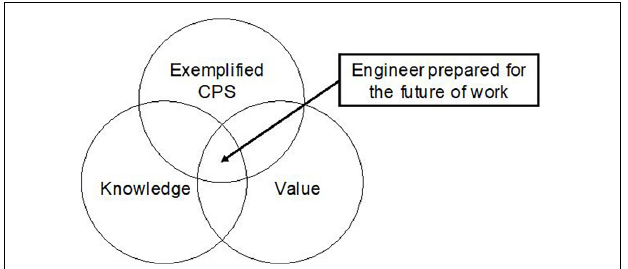
FIGURE 3 | An engineer prepared for the future of work. Exemplified creative problem solving (CPS), Knowledge of creativity, and Value of creativity in the engineering